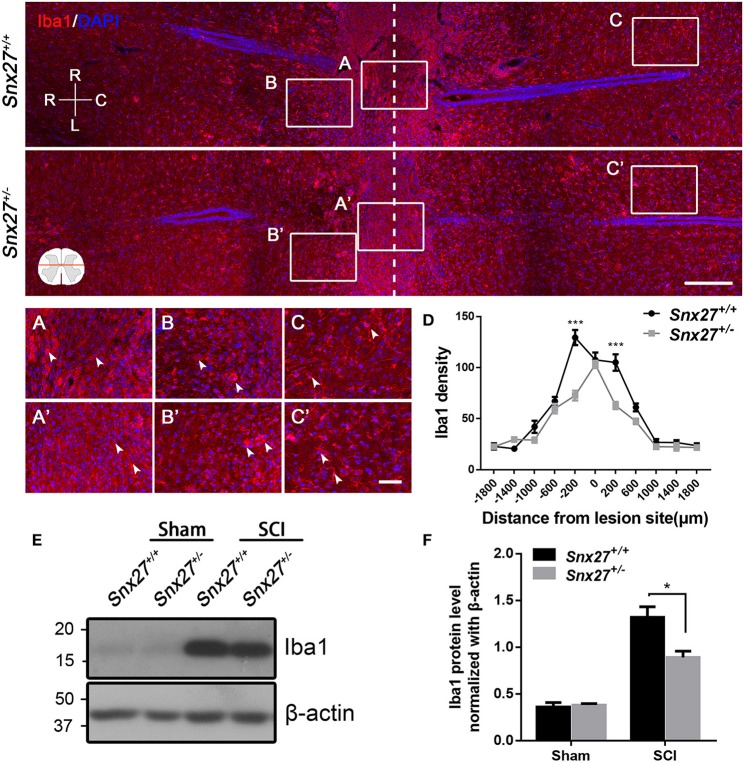
SNX27 haploinsufficiency reduces the activation of macrophage/microglia in the injured spinal cord. Top, Overview of Iba1-positive cell in horizontal sections of Snx27+/+ mice and Snx27+/− mice dorsal spinal columns, ranging from rostral 1,500 μm (–1,500 μm) to caudal 1,500 μm (+1,500 μm) around the LC. n = 6. Scale bar = 200 μm. R-C, Rostral–caudal; R-L, right–left. Dashed lines indicate the lesion center. Below, Higher magnification of the different zones: the lesion centers (A,A′); the injury boundary zones (B,B′); the non-injury zones (C,C′), Scale bar = 50 μm. Arrowheads indicate the quiescent and activated microglia. (D) Quantification of Iba1 density. (E) Western blot analysis of Iba1 expression in the spinal cords from Snx27+/+ mice and Snx27+/− mice 7 days post injury. (F) Quantitative analysis of Iba1 expression, n = 4. Values are expressed as mean ± SEM and data were evaluated by One-way ANOVA with Tukey post-hoc test. *p < 0.05, ***p < 0.001.